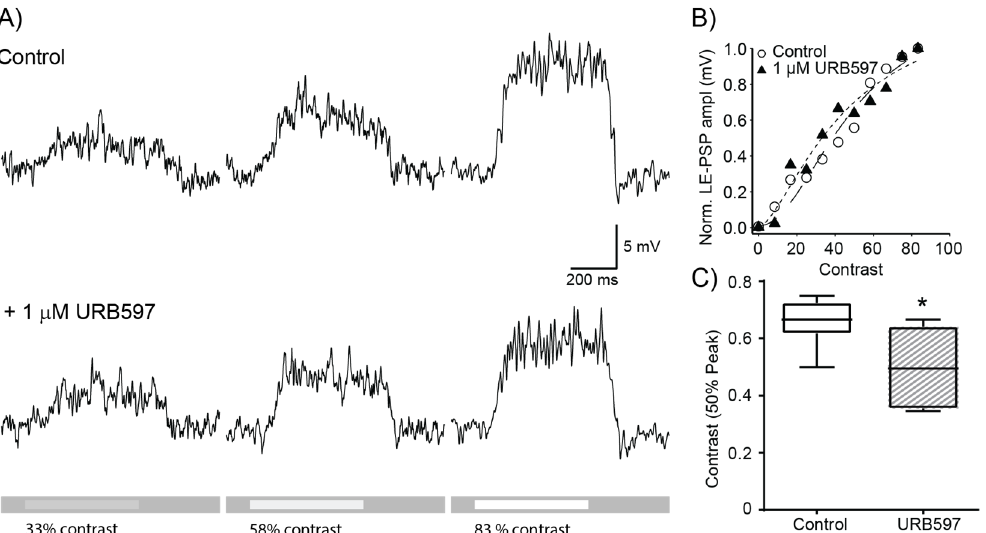
Figure 3. Effects of URB597 on contrast dependence of LE-PSP amplitude. ( A ) Light evoked postsynaptic potentials in control conditions (top traces) and in the presence of 1 µM URB597 (bottom traces) at 33, 58 and 83% stimulus contrast. Action potentials were filtered out for quantification of LE-PSP amplitude. Lighter bars on grey background at the bottom of the traces indicate the timing of stimulus delivery and stimulus contrast. ( B ) Contrast response curve for normalized peak amplitude of LE-PSP in control conditions and in the presence of URB597 for the same cell shown in ( A ). Lines denote the fit to Naka-Rushton equation (control: dashed line, URB597: dotted line). ( C ) Half-Saturation coefficients in control conditions and under 1 µM URB597. The half maximum response contrast was significantly reduced from 66 ± 4% to 50 ± 6% ( p < 0.05, n = 6) in the presence of URB597 (* p < 0.05).